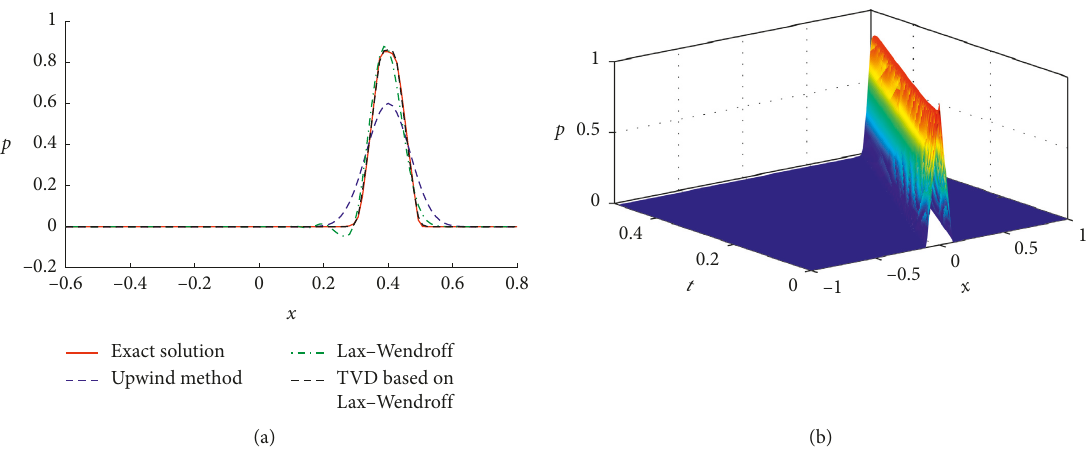
Figure 3: Solutions of equation (31) at t � 0 . 2. (a) Comparative results among different methods. (b) Entire process of solution by the method of TVD based on